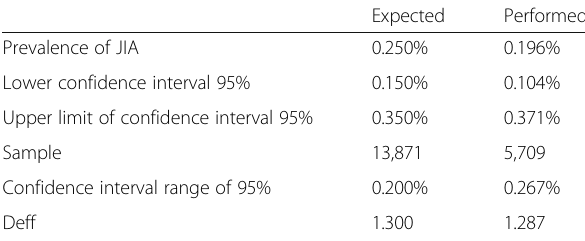
Table 3 - Prevalence, amplitude of the 95% confidence interval expected and performed